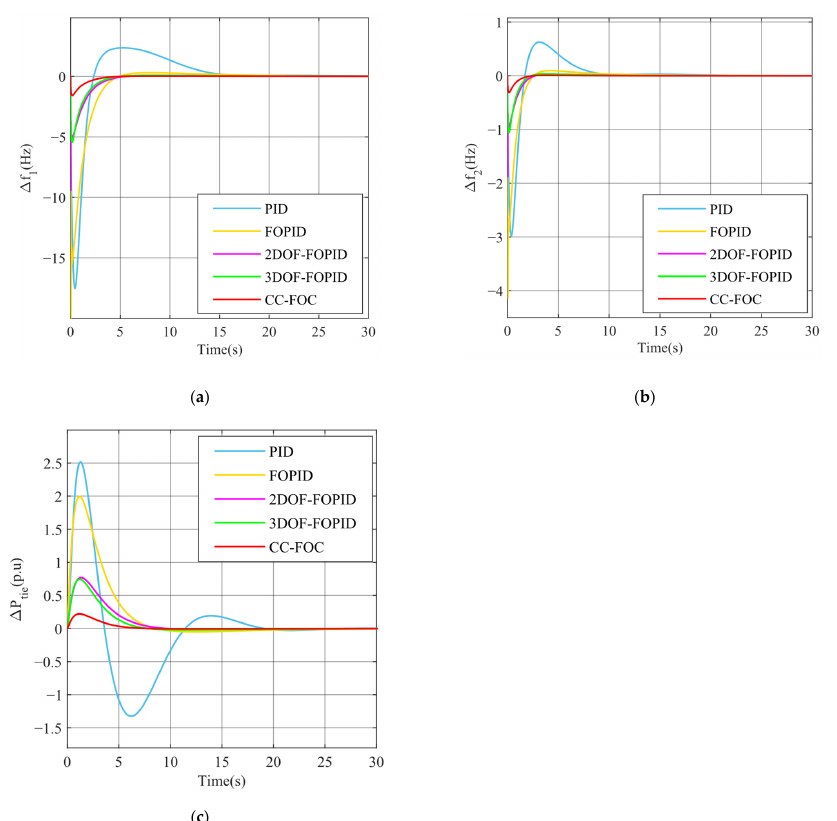
Figure 7. Dynamic performance at 2% load disturbance in area 1 and 4% load disturbance in area 2 ( a ) Δ 1 f , ( b ) 2 f Δ , and ( c ) Δ tie P . Table 2. Gains of each controller parameter. Table 3. Overshoot/Undershoot and Settling time of state variables for 2% load disturbance in area